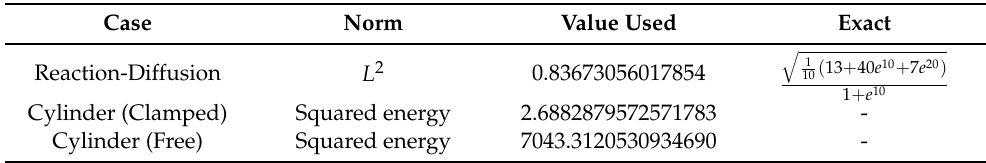
Table 1. Reference values used in numerical experiments. Reaction–diffusion with (cid:101) = 1/100 and Pitkäranta cylinder with t = 1/100. Case